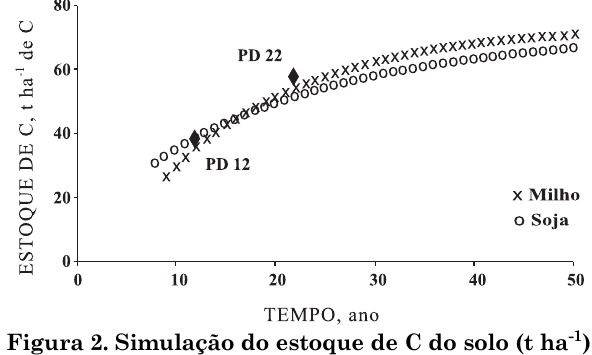
Figura 2. Simulação do estoque de C do solo (t ha -1 ) com o modelo unicompartimental para a situação de estudo no município de Tibagi (PR). Os pontos sólidos ( ) representam os valores determinados, e as sequências pontilhadas, os valores simulados, para as sucessões milho/trigo ( × ) e soja/trigo ( o